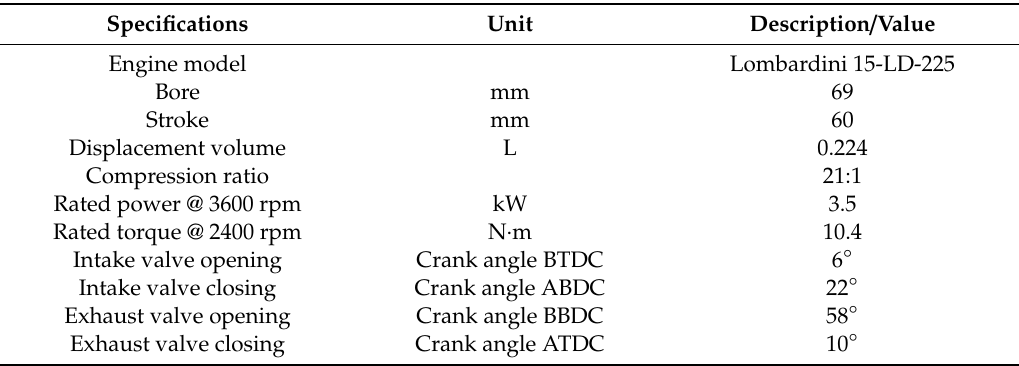
Table 6. Test engine